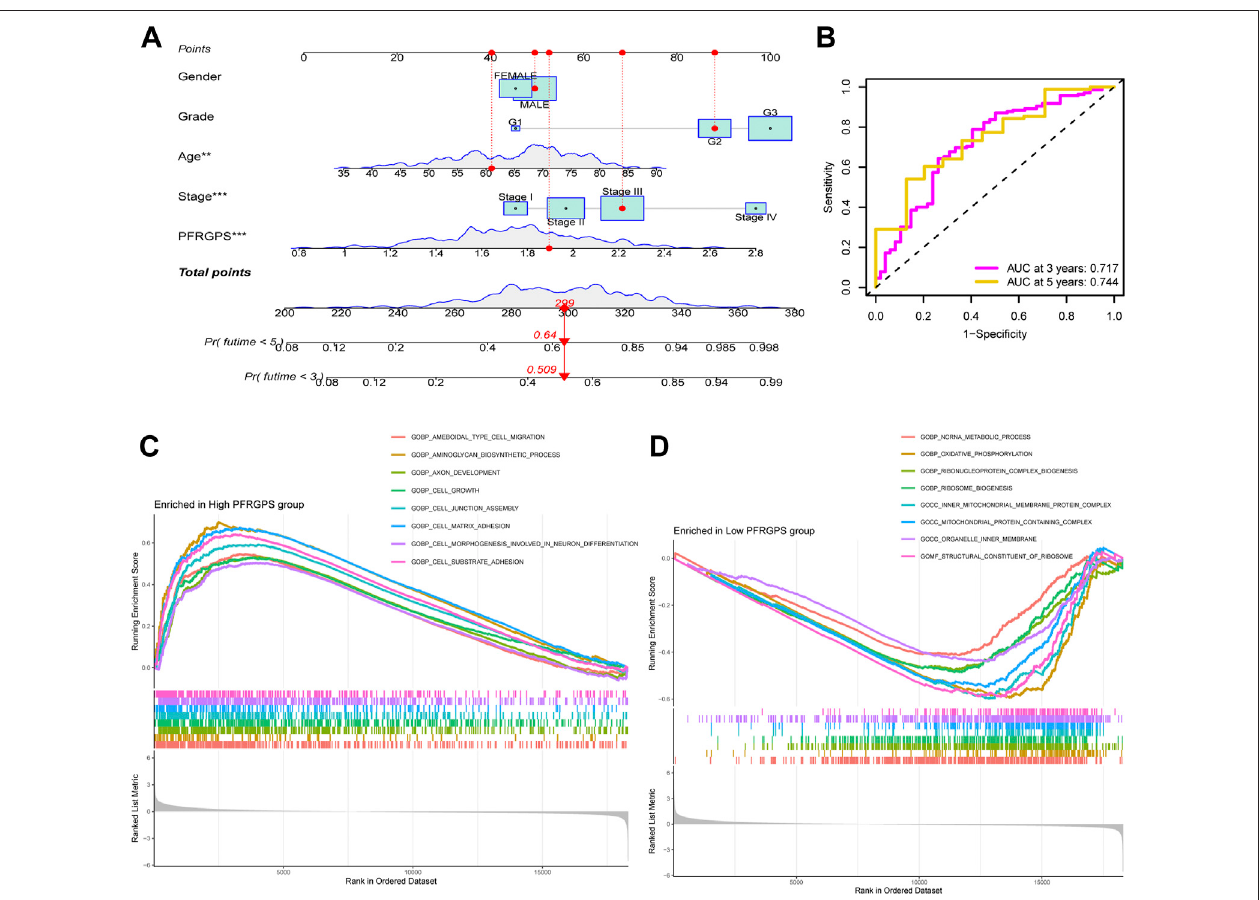
FIGURE6| NomographModelandGSEAAnalysis. (A) NomogramofPFRGPSandclinicalfactorspredictingsurvivalprobabilityofGCpatients. (B) TheROCcurve veri fi es the predictive ability of the nomogram. (C) GSEA enrichment analysis in the high-PFRGPS subgroup. (D) GSEA enrichment analysis in the low-PFRGPS subgroup.PFRGPS,plateletfunction-relatedgenesprognosticscore.GSEA,GeneSetEnrichmentAnalysis;PFRGPS,plateletfunction-relatedgenesprognosticscore; GC, Gastric cancer; ROC, receiver operating characteristic. * p < 0.05, ** p < 0.01, *** p <